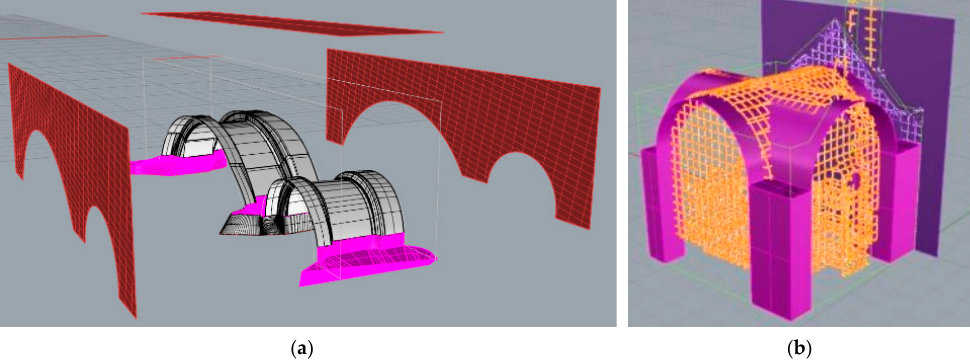
Figure 12. Three-dimensional model created in Rhinoceros environment: exploded structural elements of the bridge ( a ); 3D model of the San Nicola in Montedoro church ( b ).